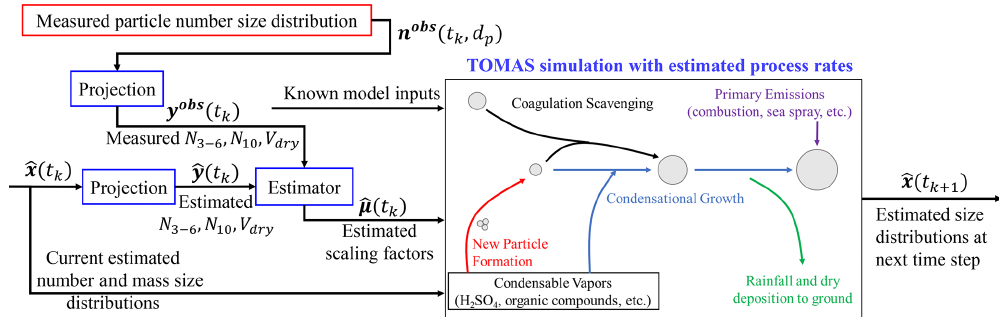
Figure 1. Schematic of the TOMAS box model with the online estimation technique. The measured size distribution is projected to the inventory variables ( N 3–6 , N 10 , V dry ), which the estimator compares to the current model prediction to calculate scaling factors that adjust particle formation, SOA production, and POA emission rates in TOMAS to simulate the size distribution with adjusted rates at the next time